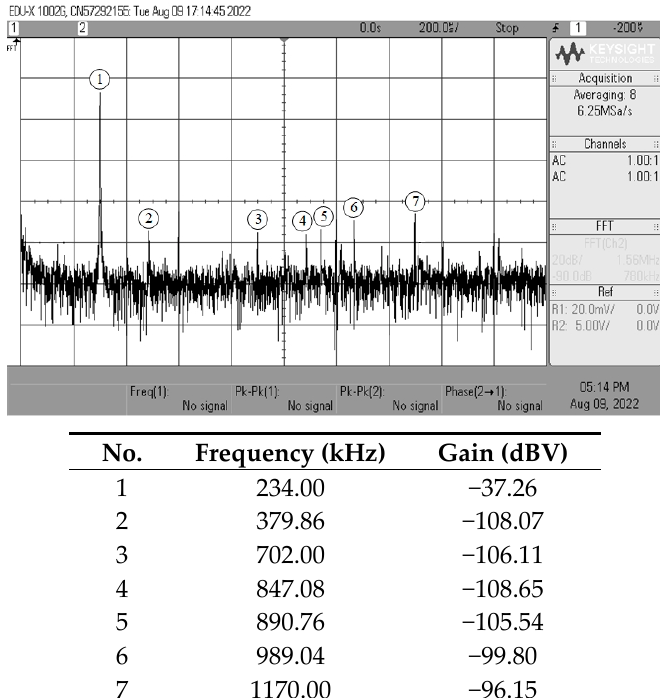
Figure 17. Experimentally observed frequency spectrum of v o(VM) of the AP filter in VM.